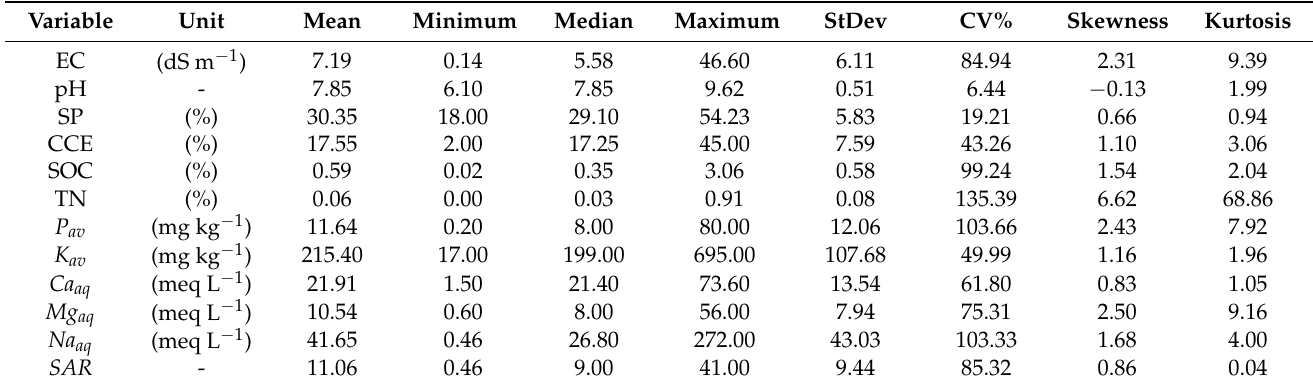
Table 1. Descriptive statistics of soil properties in the study area ( n =